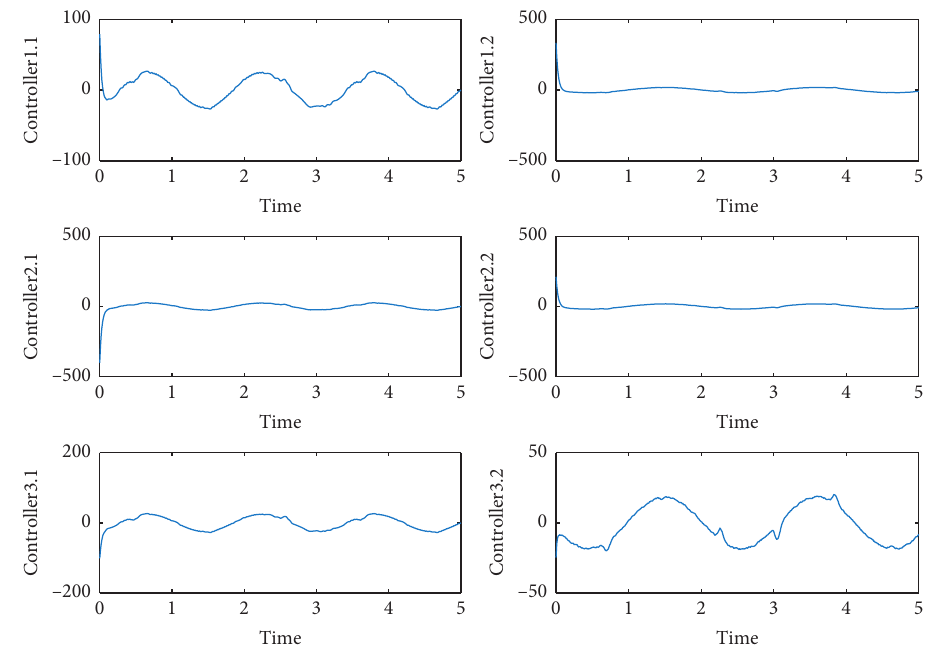
Figure 5: The first and second coordinates of the three